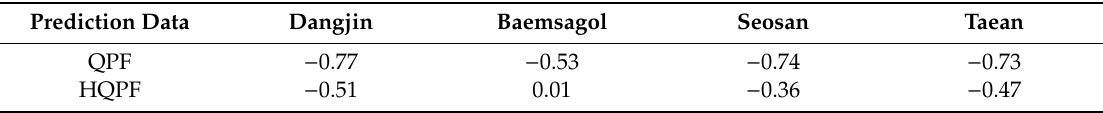
Table 10. NPE (mm / 3 h) by